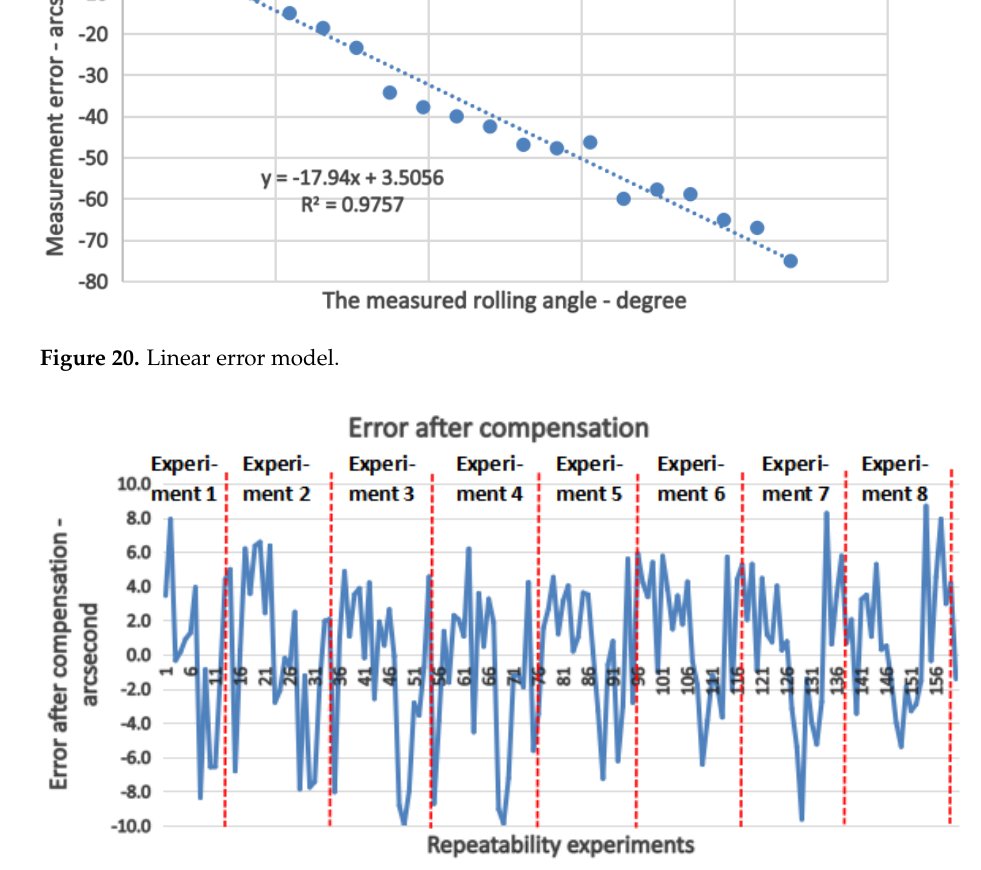
Figure 21. Error after compensation.